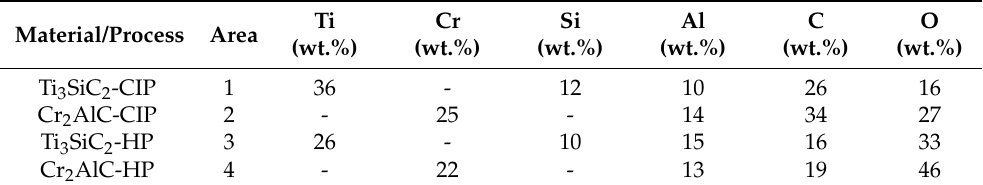
Figure 16. SEM secondary electron and back-scattered detectors micrographs of the reciprocating- sliding wear test with an applied load of 5 N for ( a ) cold isostatic pressed and sintered (CIP) Ti 3 SiC 2 ; ( b ) cold isostatic pressed and sintered (CIP) Cr 2 AlC; ( c ) hot-pressed (HP) Ti 3 SiC 2 and ( d ) hot-pressed (HP) Cr 2 AlC. Table 6. An EDS area analysis of the wear tracks produced with a load of 5 N shown in the micrographs in Figure 16 for the cold isostatic pressing (CIP) and hot-pressed (HP) samples of the Ti 3 SiC 2 and Cr 2 AlC MAX